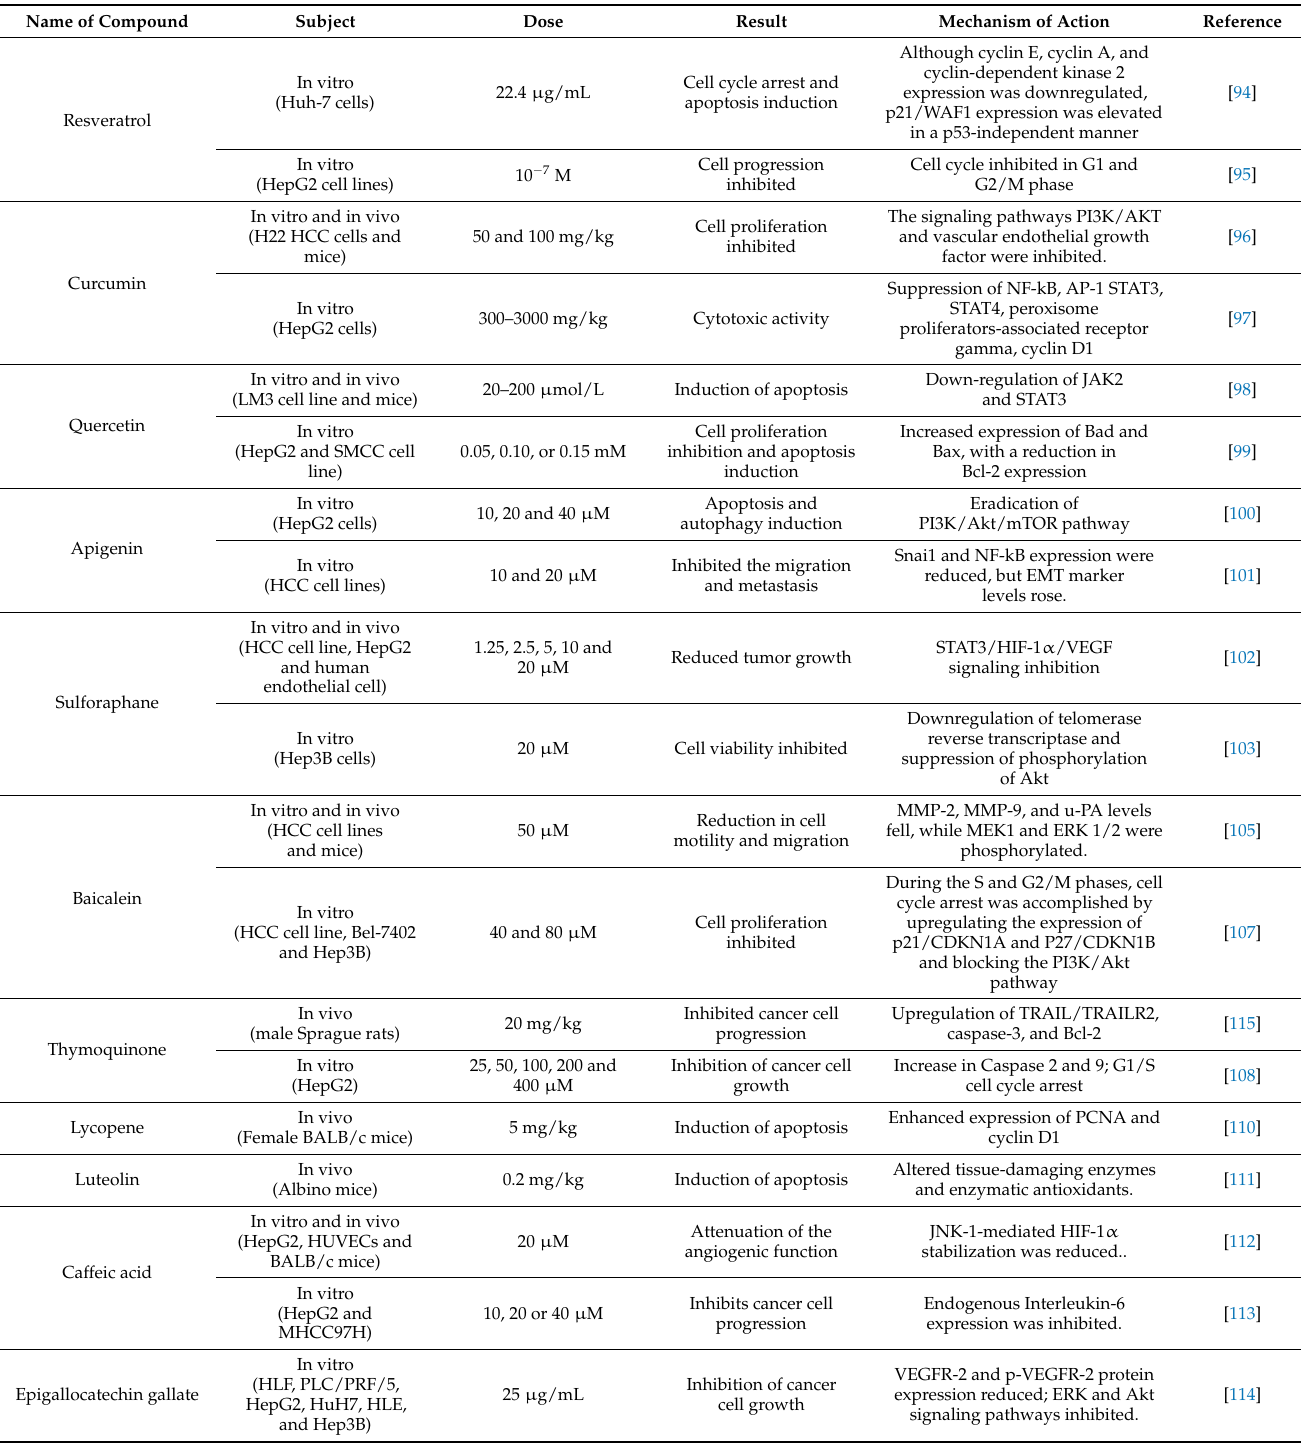
Table 3. Natural small molecules in hepatocellular